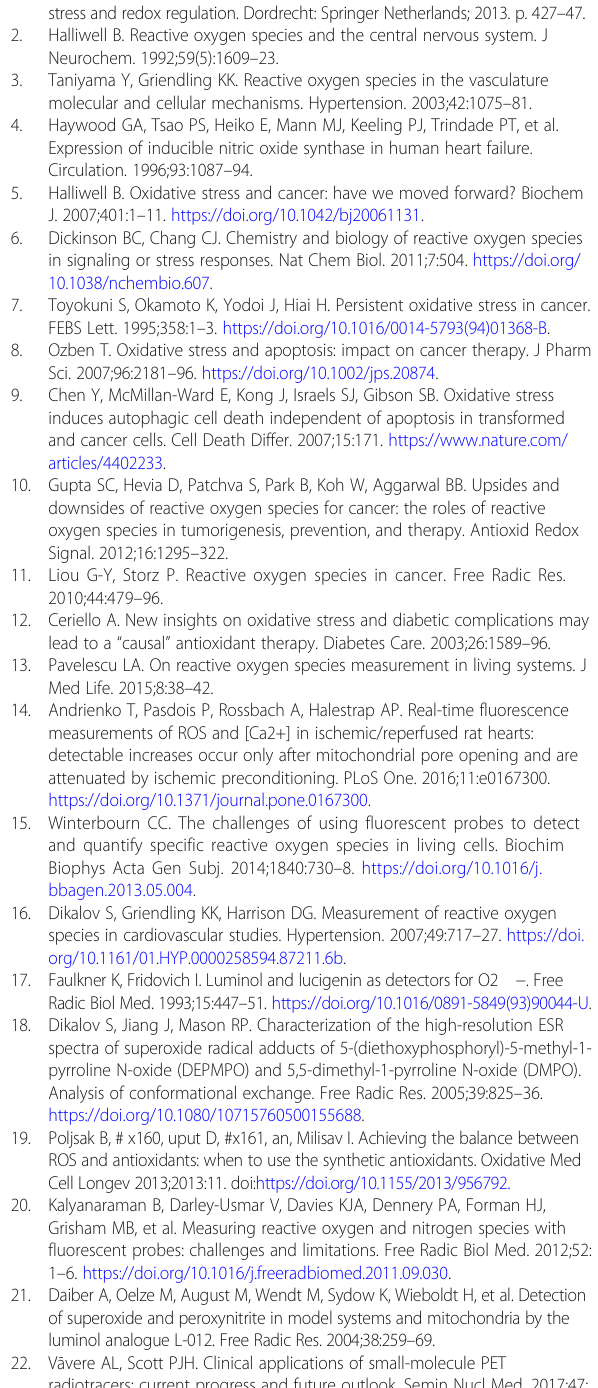
Figure S2. Ex vivo stability of 18 F-KS1 in human serum sample; radiochemical purity analyzed until 240min after production (DOCX 210